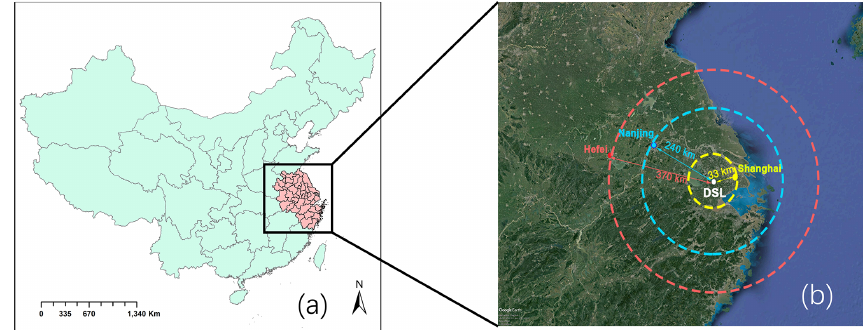
Figure 1. (a) Map of China with the YRD region highlighted in pink. (b) Satellite map of the YRD region (created with © Google Earth on 23 July 2020). Table 1. Measurements performed during the ozone season. Species/parameter Experimental technique Time resolution Lower detectable limit O 3 Model 49i, Thermo Fisher Scientific, USA NO and NO 2 Model 42i, Thermo Fisher Scientific, USA AL4021, Aero-Laser, GER Temperature, relative humidity, Meteorological station, Vaisala,